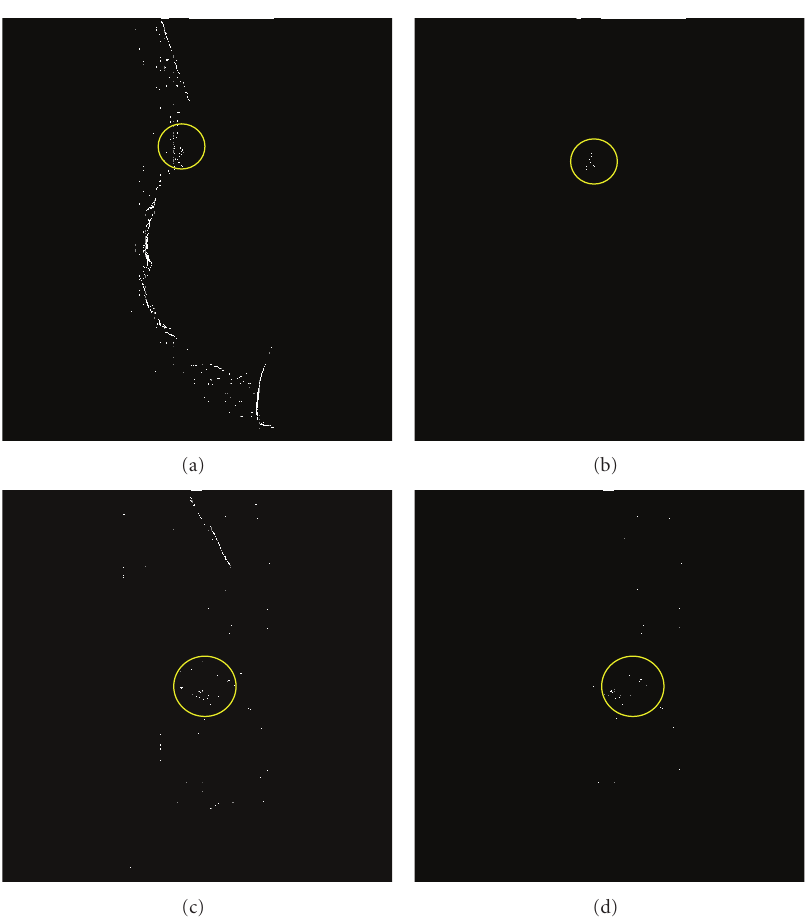
Figure 9: Improving the FP rate of the detection results using Otsu’s thresholding: (a) and (c) results without post-processing, (b) and (d) post processing using Otsu’s thresholding.